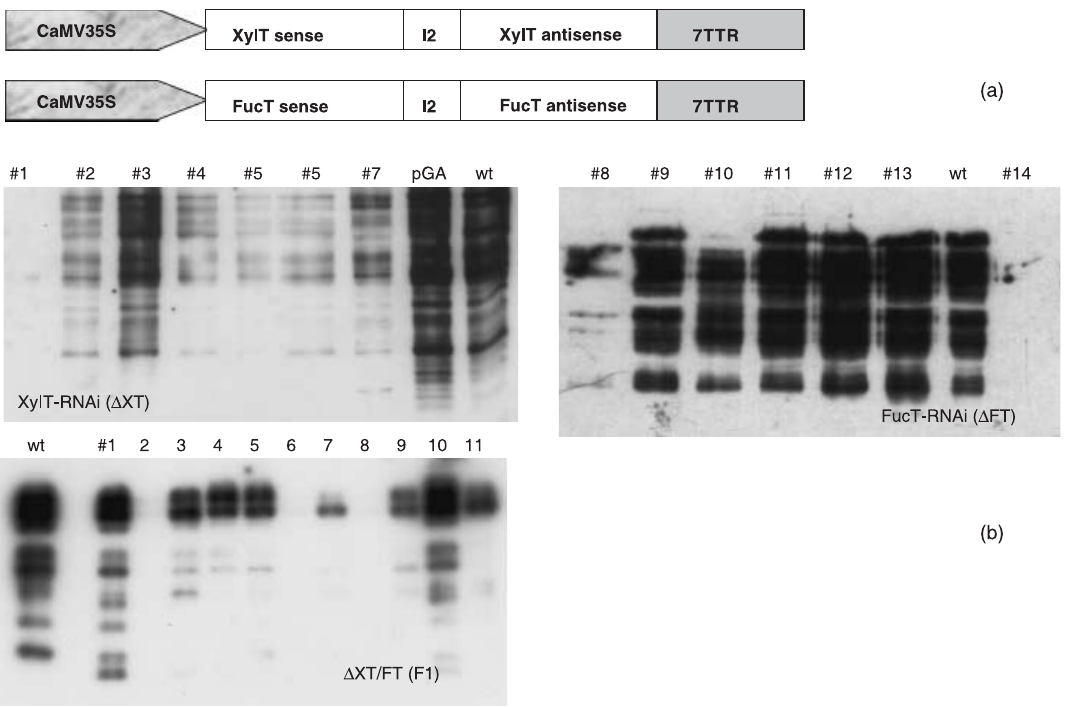
Figure 1 (a) XylT- and FucT-RNAi constructs [RNA interference constructs targeting the expression of endogenous β 1,2- xylosyltransferase (XylT) and α 1,3- fucosyltransferase (FucT) genes] used for Nicotiana benthamiana transformation. CaMV35S, cauliflower mosaic virus 35S promoter; I2, intron;